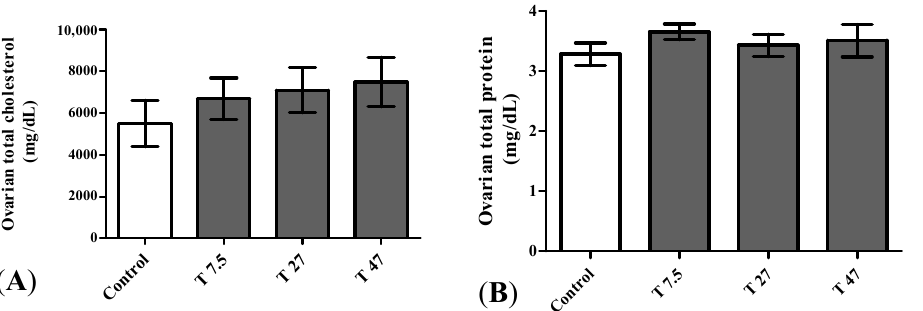
Figure 7. Effect of tartrazine on ovarian total cholesterol ( A ) and ovarian total protein ( B ) of immature female Wistar rats after 40 days of treatment. Control = animals receiving vehicle (distilled water, 10 mL/kg BW); T = rats treated with tartrazine at doses of 7.5; 27, and 47 mg/kg BW. Results are shown as a mean ± SEM; n = 5.